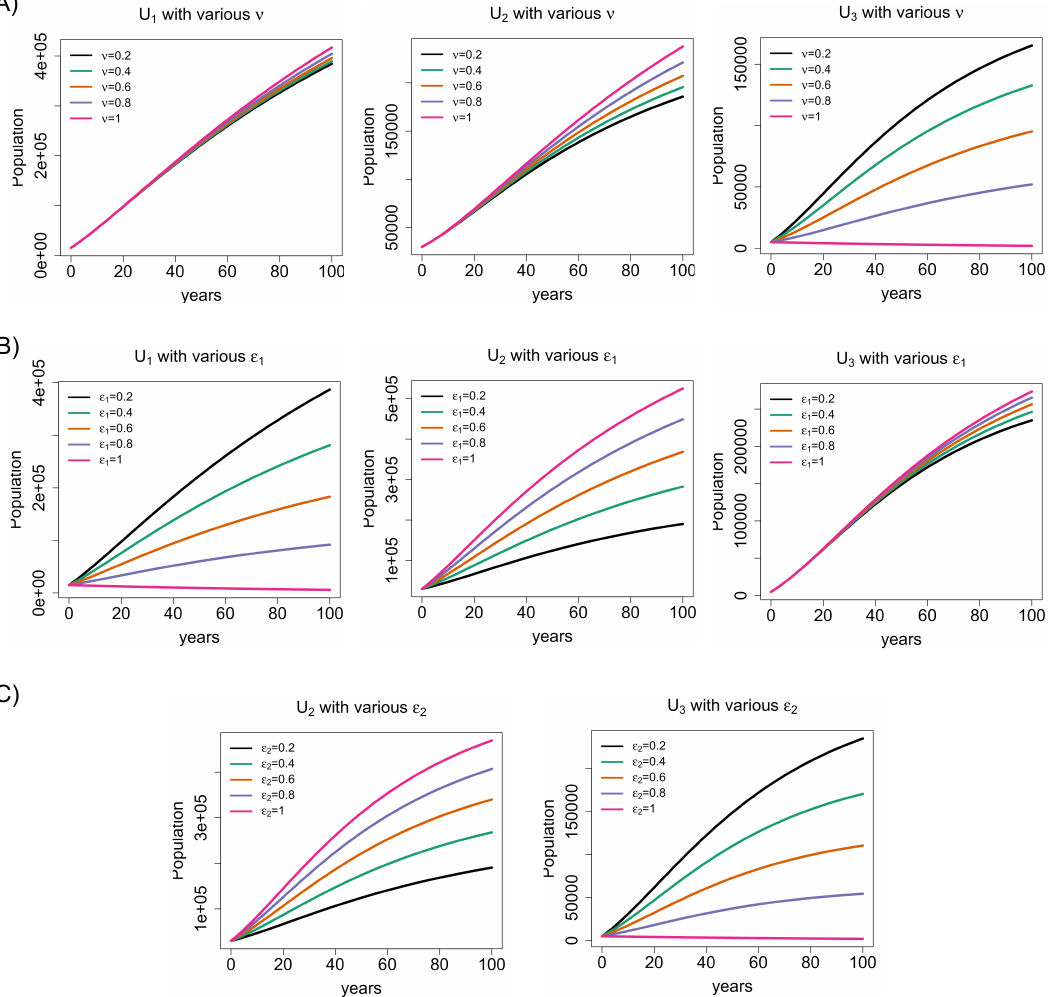
Figure 2. Hypothetical situations of all normal married with carriers and vice versa.